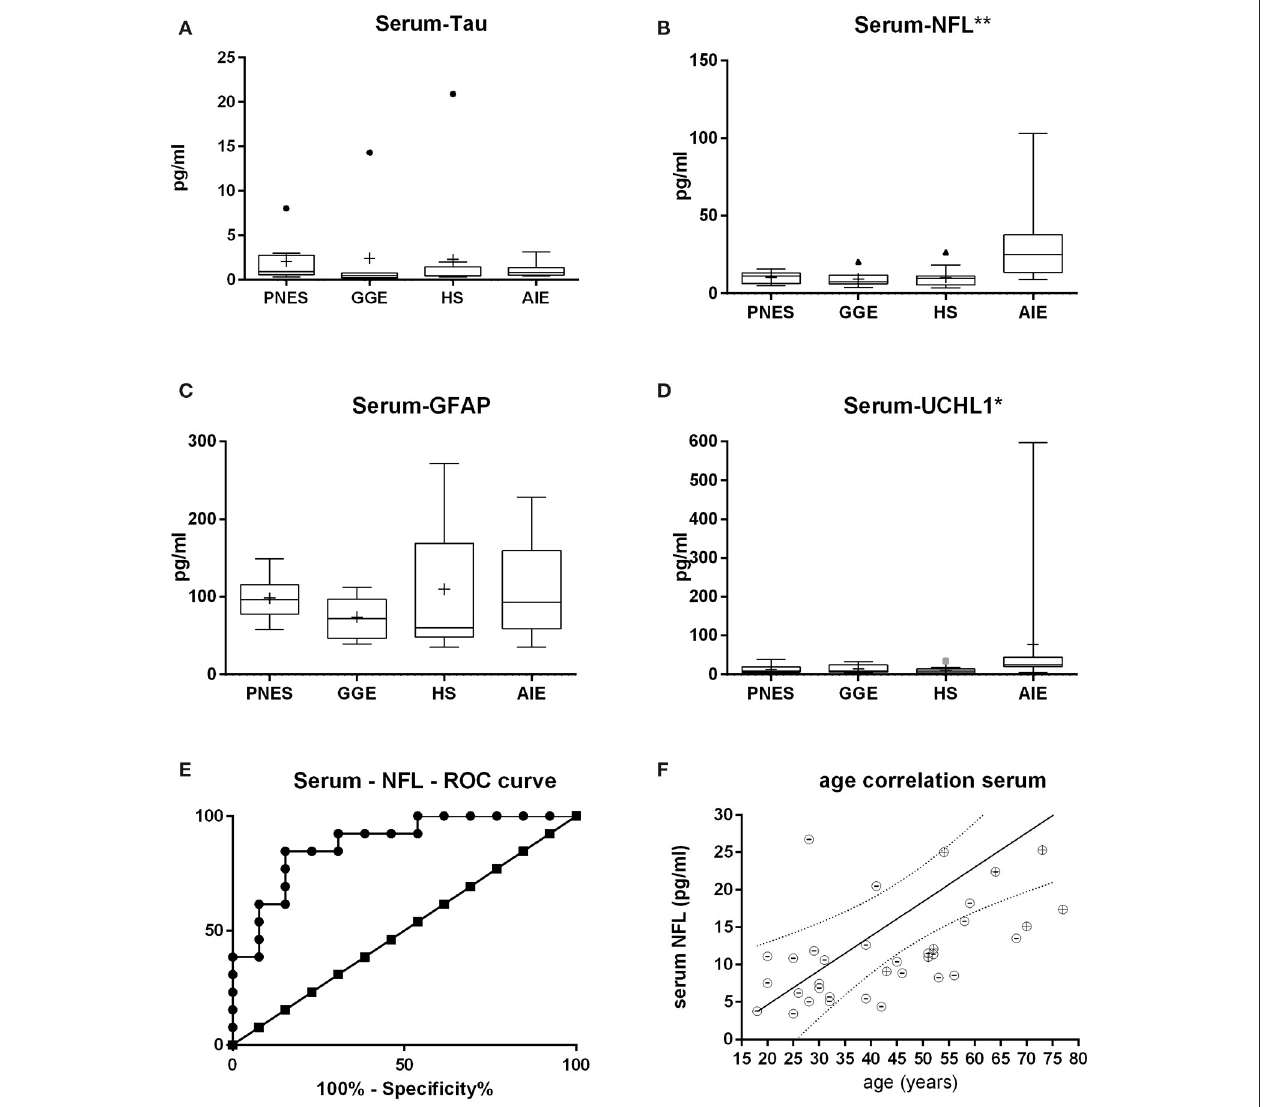
FIGURE 1 | Serum levels of tau (A) , neurofilament (NFL) (B) , glial fibrillary acid protein (C) , and ubiquitin-carboxy-terminal hydrolase L1 (D) . Only NFL shows both a statistically significant and biologically robust difference in between groups since the difference in UCHL1 is mostly due to outliers. At first glance, the receiver operating characteristic curve (E) indicates that serum NFL may be of decent value in the question on whether epilepsy might be autoimmune-related. Of note is the fact that this may likely be a result of age alone since age strongly correlates with NFL levels both in AIE (“ + dots”) as in other etiologies (“-dots”) (F) . * p < 0.05, ** p < 0.001.